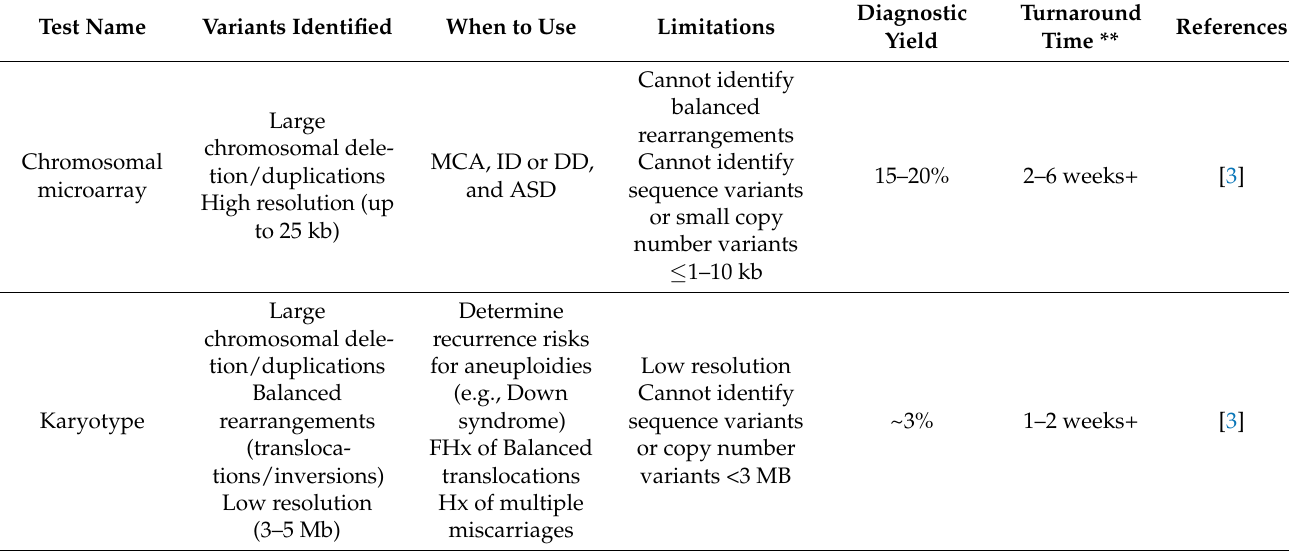
Table 1. Overview of common genetic